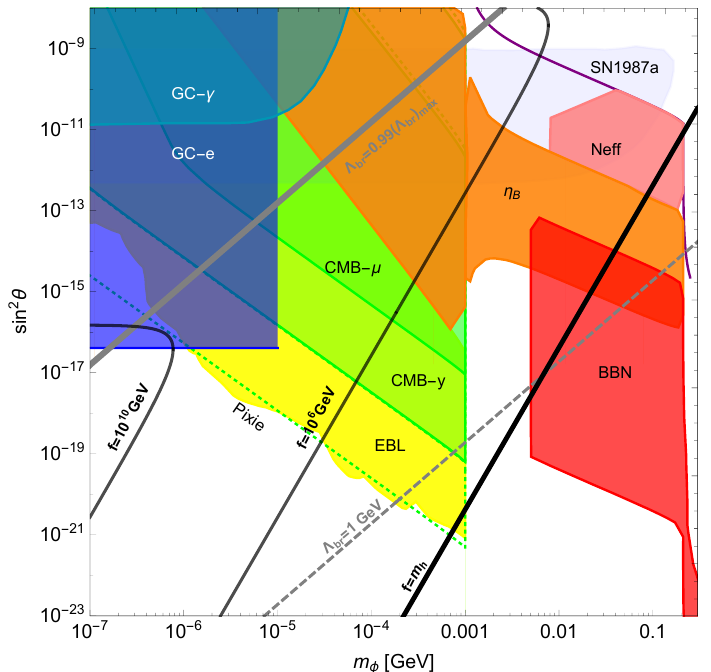
Figure 5 . Cosmological and astrophysical bounds on sin 2 (cid:18) and m (cid:30) from 100 eV to 0 : 3 GeV: globular cluster via coupling to electrons (blue) or coupling to photons (turquoise), supernova 1987a (light blue), extragalactic background light (EBL, yellow), CMB y -distortion (light green) and (cid:22) - distortion (green), entropy injection (cid:1) S=S bounded by the baryon-to-photon ratio (cid:17) B (orange) and by N e(cid:11) (pink), BBN (red). The green dotted lines represent the projection for the sensitivity of PIXIE to CMB distortions.The light gray band indicates the possible range of sin 2 (cid:18) for j = 1, i.e. the QCD case. The gray lines (from top to bottom) are contours of constant (cid:3) br = 0 : 99(cid:3) max (thick, br solid), and 1 GeV (dashed). Here (cid:3) max is the upper bound on (cid:3) br arising from the requirement p br of a non-tachyonic (cid:30) in eq. (3.12) for sin( (cid:30) 0 =f ) = 1 = 2. The black lines (from left to right) are contours of constant f = 10 10 GeV ; 10 6 GeV (thin) and f = m h